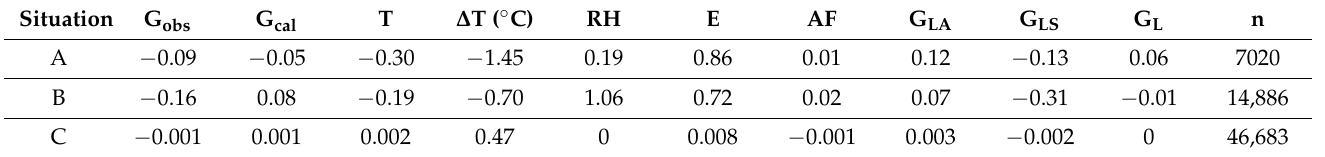
Table 4. Change rate (%) of the monthly mean solar radiation and its losses and meteorological pa- rameters (air temperature T and its change ∆ T ( ◦ C), relative humidity (RH), and water-vapor pressure E (hPa) in January 2008–December 2011 (model development, situation A), January 2008–December 2011 (whole measured dataset, situation B), and January 2007 to December 2020 (situation C). The change rate of each variable was calculated using c 1 × 100/c 0 , and the linear relation between each variable (y) and time (month, x) was determined as y = c 1 x + c 0